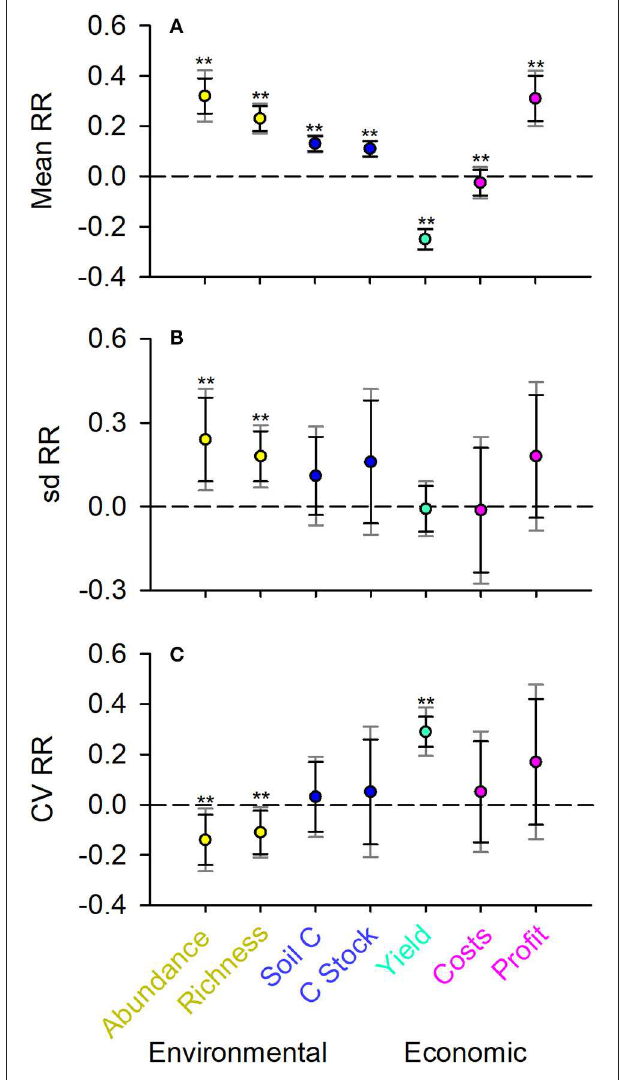
FIGURE 2 | (A) Mean response ratio, (B) standard deviation response ratio, and (C) coefficient of variation response ratio of organic compared to conventional farming systems for seven sustainability metrics. All values shown are means ± 90% CI (black) and ± 95% CI (gray). **Indicates 90% and 95% CIs did not overlap